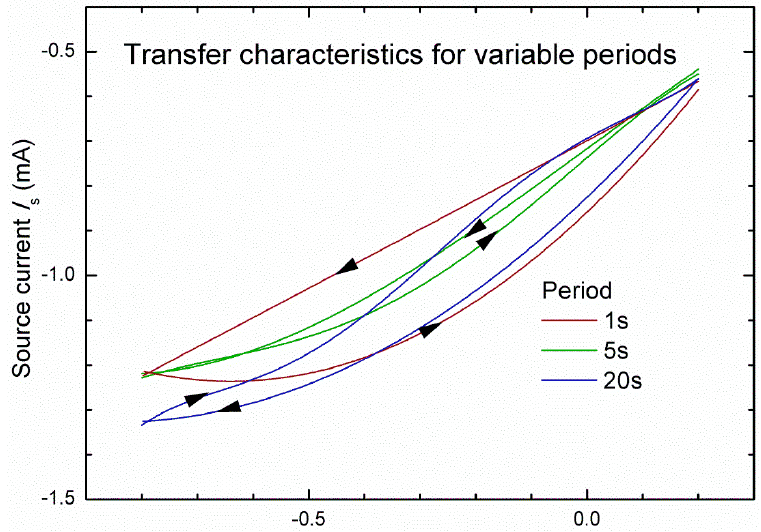
Figure 3. Transfer characteristics measured at the triangular gate periodic voltage at various periods.